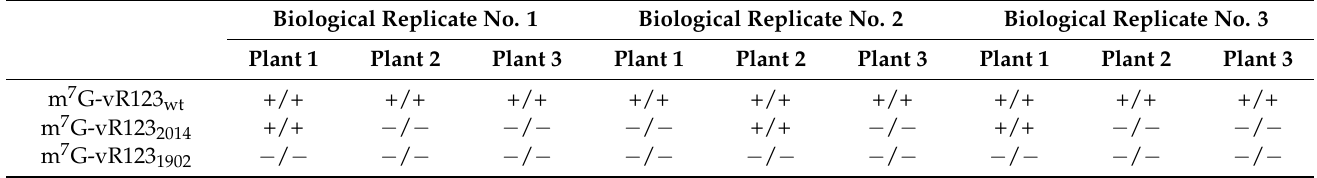
Table A2. Detection of AMV by Northern blot assays in three biological replicates performed in N. benthamiana, after inoculation with infectious transcripts (wild-type and